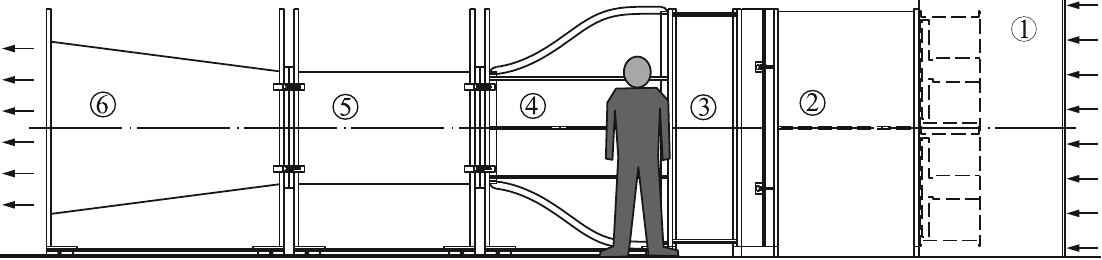
Figure 7. Sketch of the S4 wind tunnel of the IDR/UPM Institute devoted to anemometer calibration. (1). Fans; (2). Plenum chamber; (3). Honeycomb and grids; (4). Contraction; (5). Test chamber; (6).